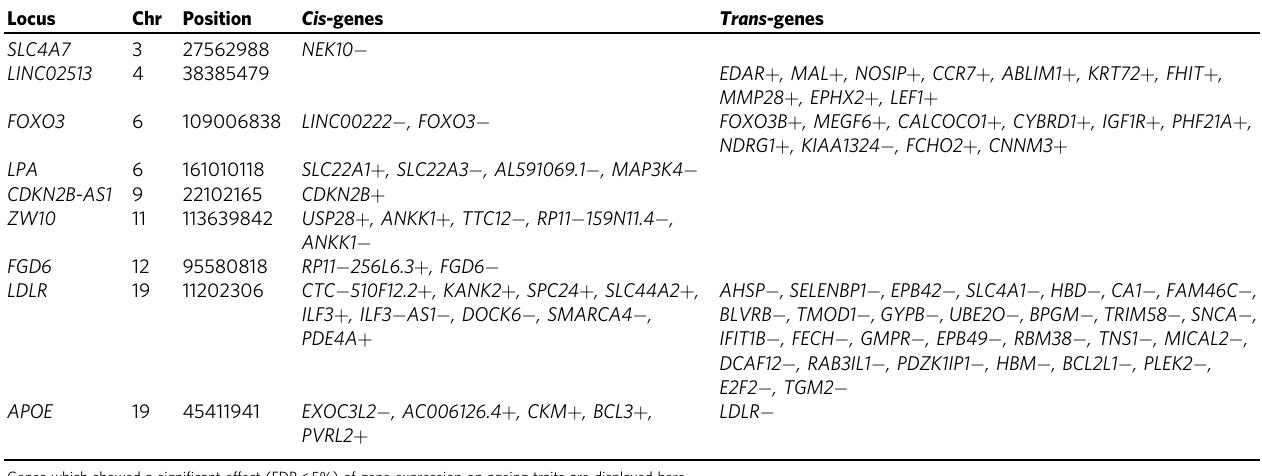
Table 2 eQTL for 78 genes colocalise with the GWAS signal at 9 out of 10 loci of